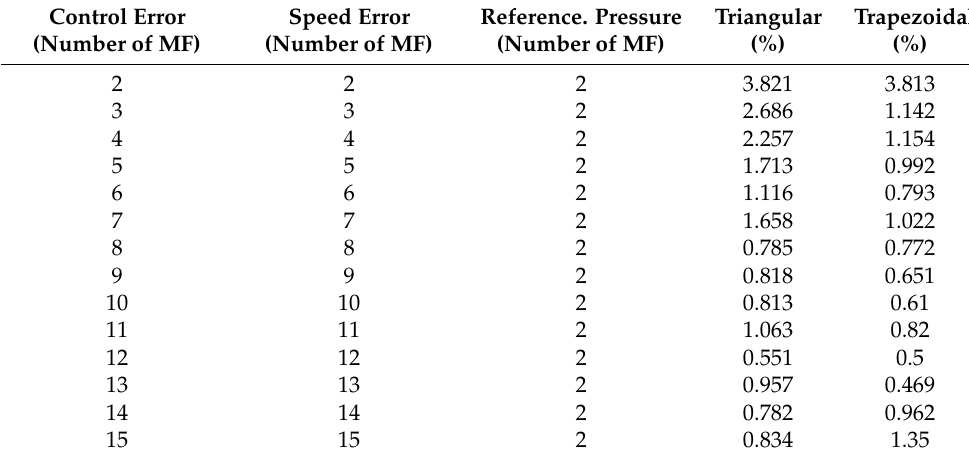
Table 1. Results from the training process—set 1.